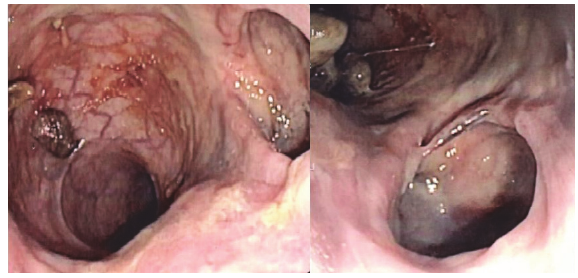
Figure 1: Endoscopic view of pseudodiverticula of the rectum.